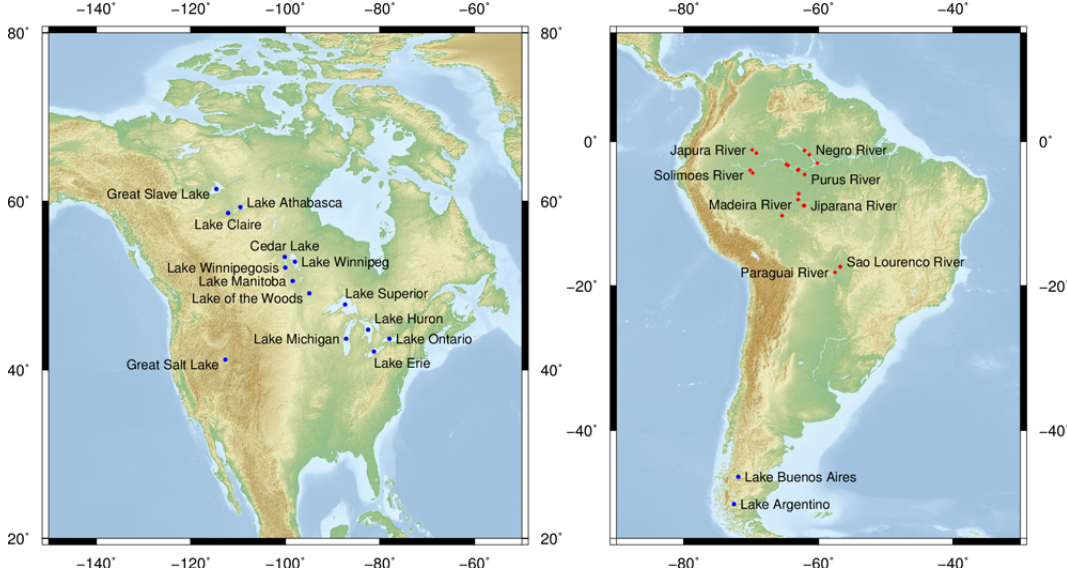
Figure 5. Map of selected study areas of lakes (blue) and rivers (red) in North America (left) and South America (right).